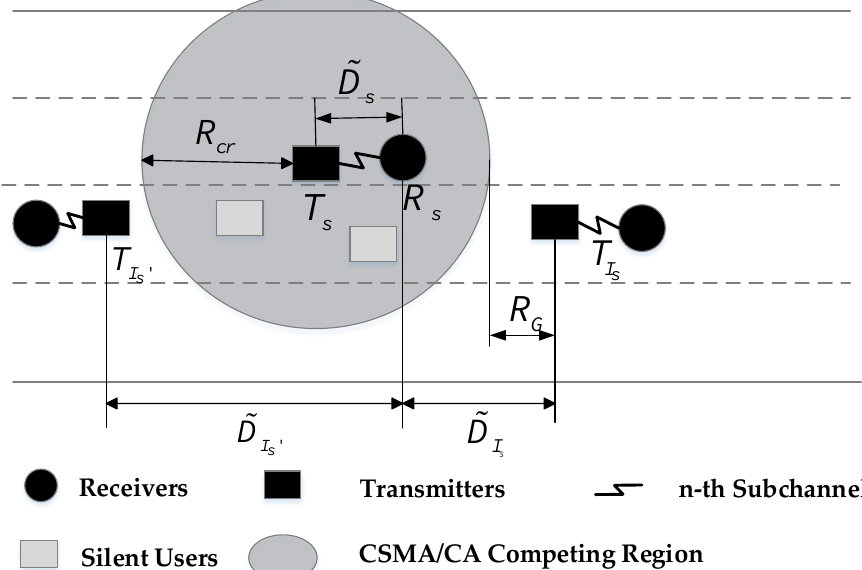
Figure 4. Interfered scenario.